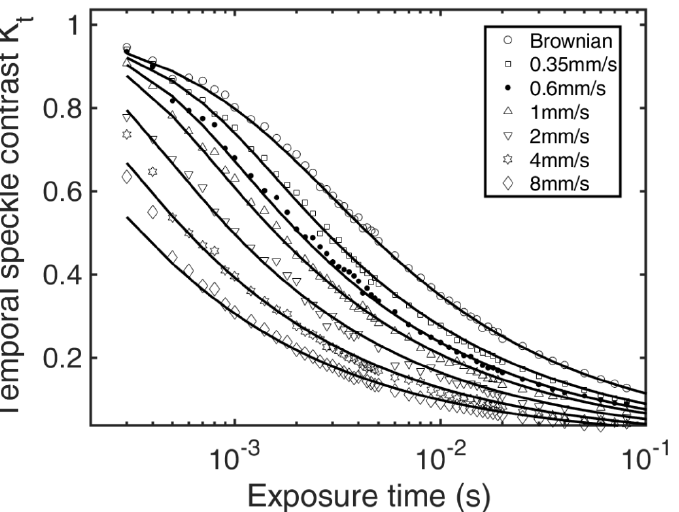
Figure 2. Measured temporal speckle contrast of flow phantom (data points) and corresponding fitting results (solid lines) for different flow velocities using LS-TSCI setup.